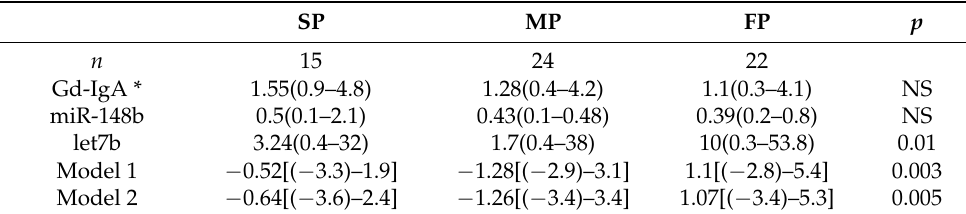
Table 4. Differences in serum concentration of Gd-IgA1, miR-148, and let-7b and in Models 1 and 2